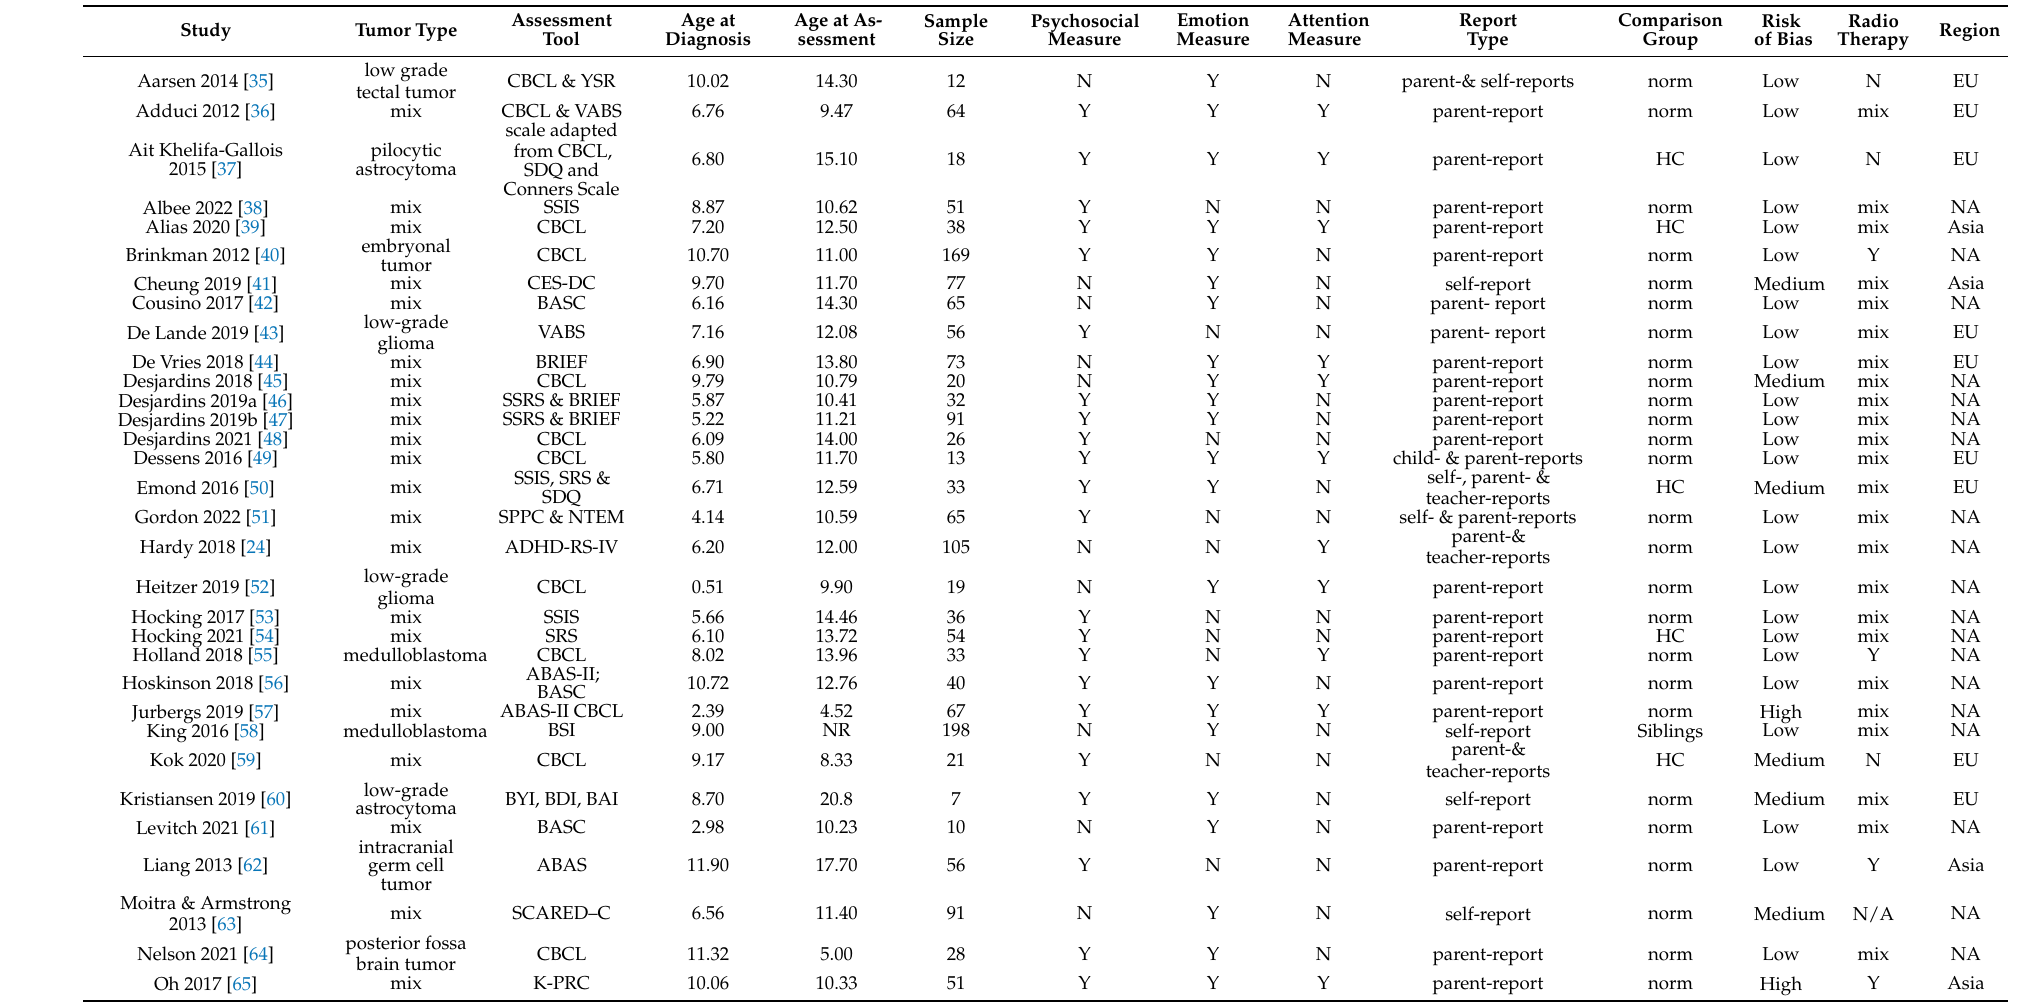
Table 1. Characteristics of the included